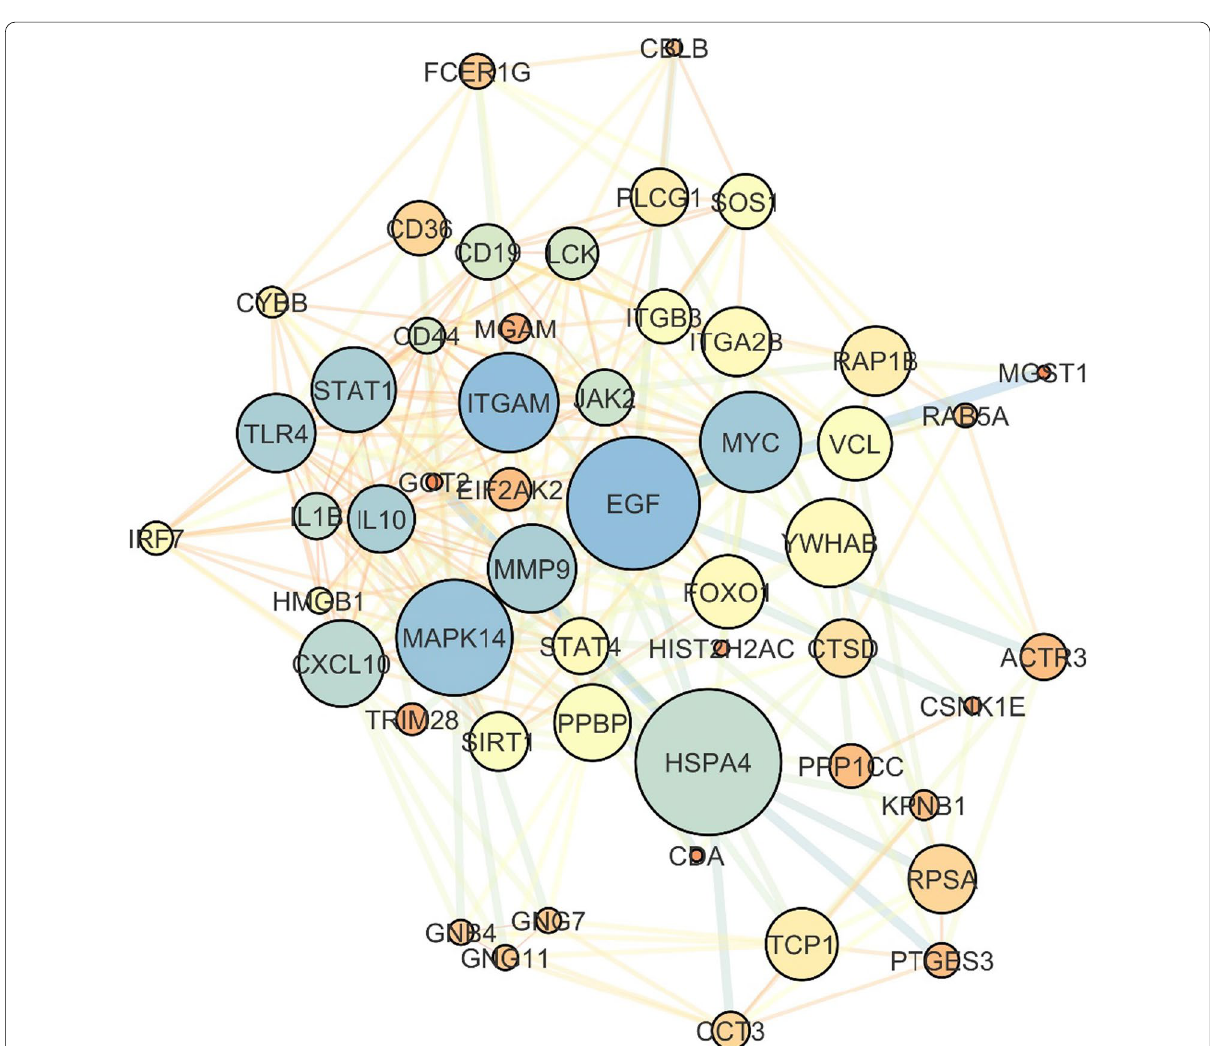
Fig. 6 Topology of the backbone network that consists of 52 nodes with a high BC value and 296 edges. The size of the nodes corresponds to their BC